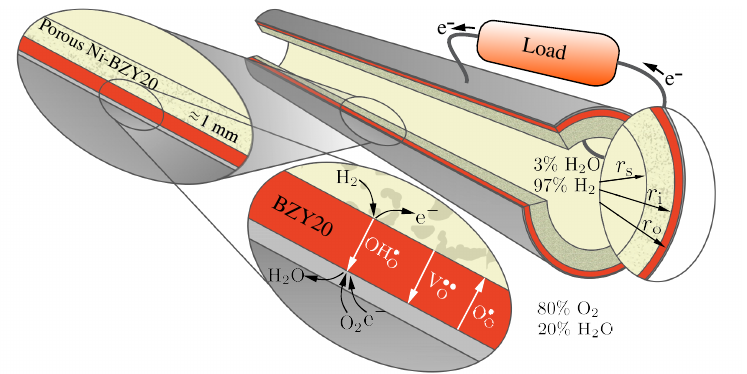
Figure 1. Proton-conducting tubular cell consisting of a dense BZY20 electrolyte supported by porous Ni-BZY20 operating as a fuel